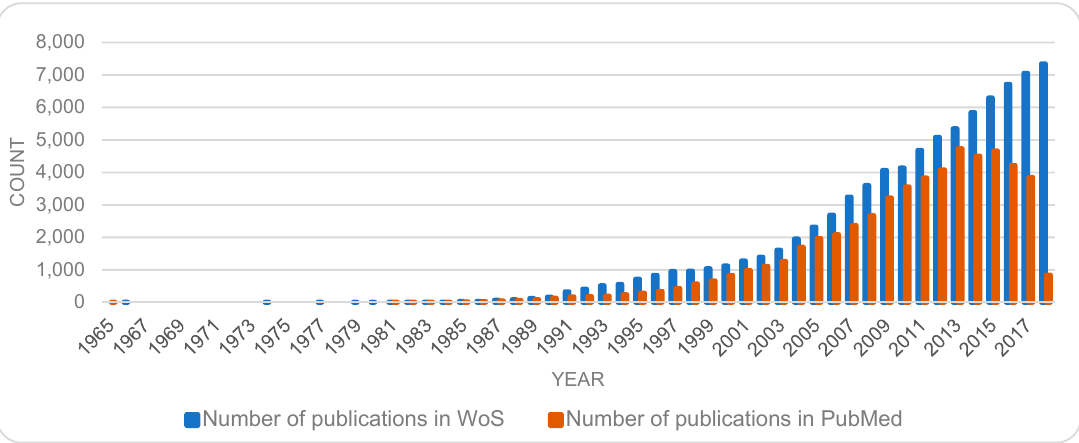
Figure 2. Yearly publication counts on biosensor(s) based on Web of Science data captured in May 2019. The publication trend based on the original PubMed data from 2018 is also included as a point of reference.